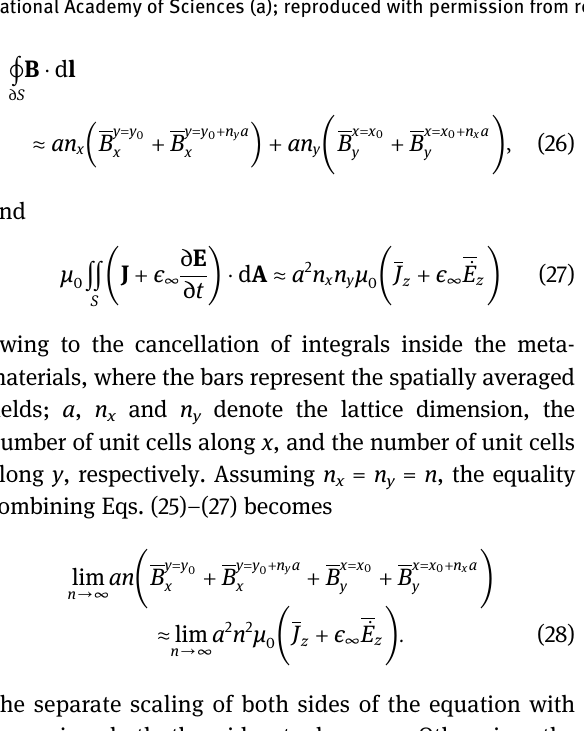
Figure 5: (a) Photonic band structure of double gyroid metamaterial. (b) Negative refraction of double gyroid metamaterial, where red arrows represent photonic energy flux, and k -vector represents wave momentum. (c) Refractive index variation as a function of lattice dimension, a . (d) Schematic of plasmon resonances to satisfy the electric current conservation. Reproduced with permission from ref. [29]. Copyright 2018, National Academy of Sciences (a); reproduced with permission from ref. [2]. Copyright 2011, Wiley-VCH Verlag GmbH Weinheim (b) –